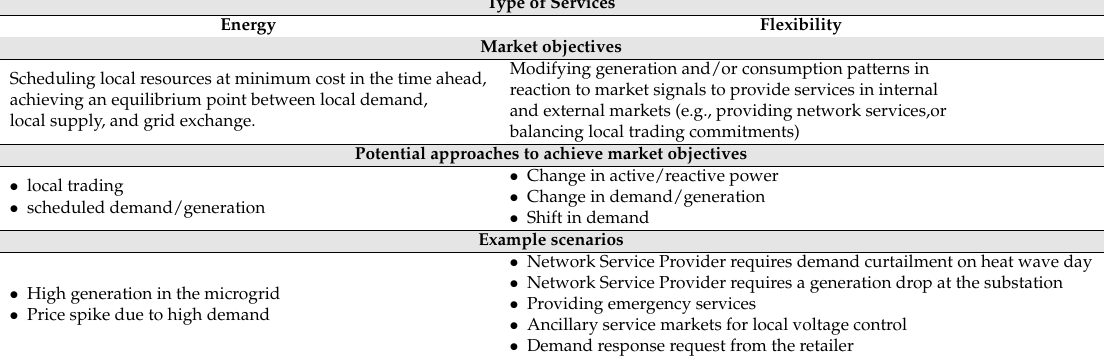
Table 1. Different scenarios for transactive energy market (TEM)